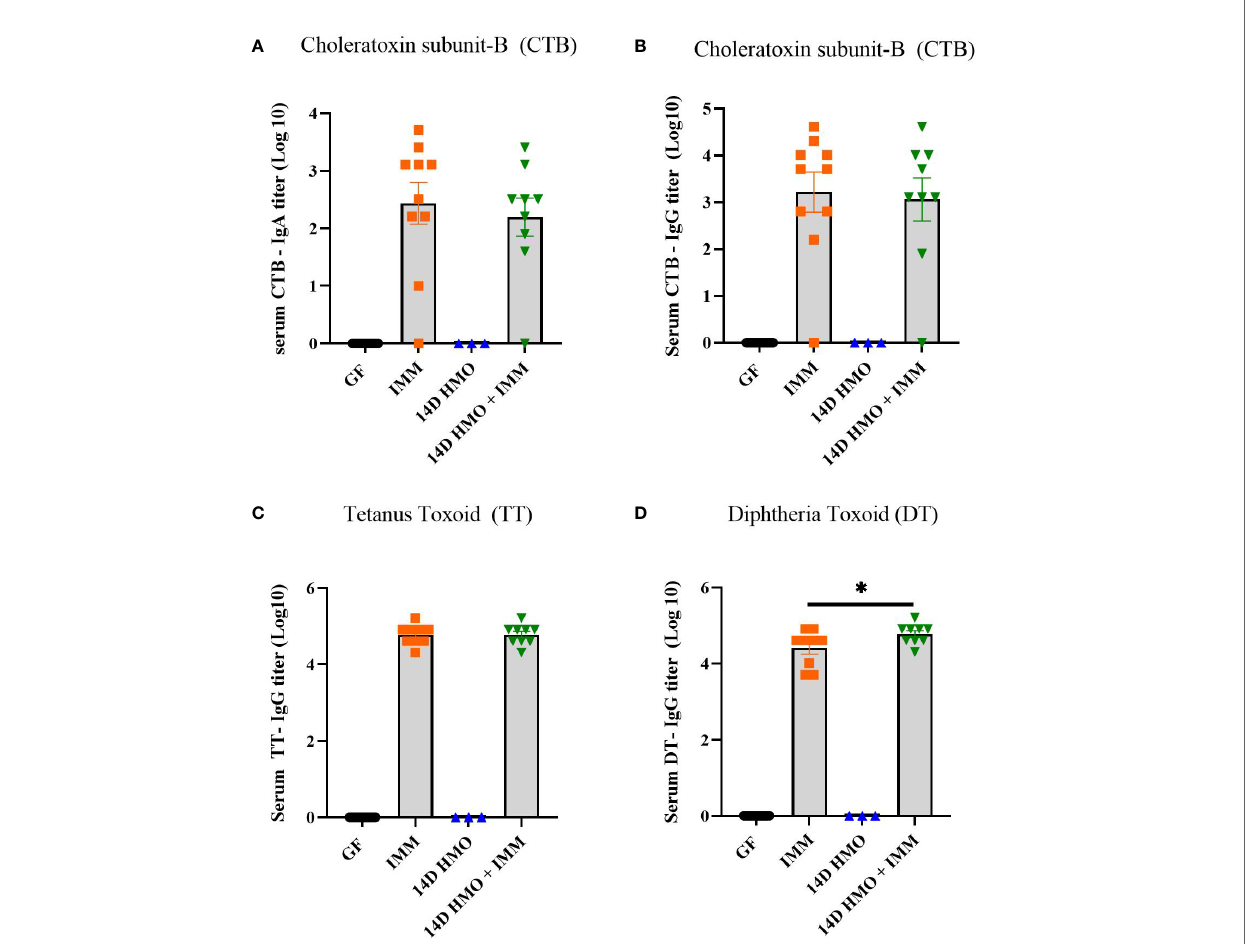
FIGURE 9 | Serum IgA and IgG titers in immunized or HMO-supplemented groups. (A) CTB-speci fi c serum IgA (B) CTB-speci fi c IgG (C) TT-speci fi c serum IgG (D) DT-speci fi c IgG. GF control (n = 16, M = 8, F = 8), immunized (IMM) (n = 10, M = 6, F = 4), 14-day (14D) HMO (n = 3, F = 3) and 14D HMO + IMM (n = 9, M = 4, F = 5). Statistical signi fi cance between control and treatment groups were determined using one-way ANOVA with Bonferroni ’ s multiple comparison correction in GraphPad Prism Version 9.3.1 and adjusted p-value <0.05 was considered signi fi cant. Outliers were removed using ROUT (Q = 1%) in GraphPad Prism Version 9.3.1.* indicates signi fi cance